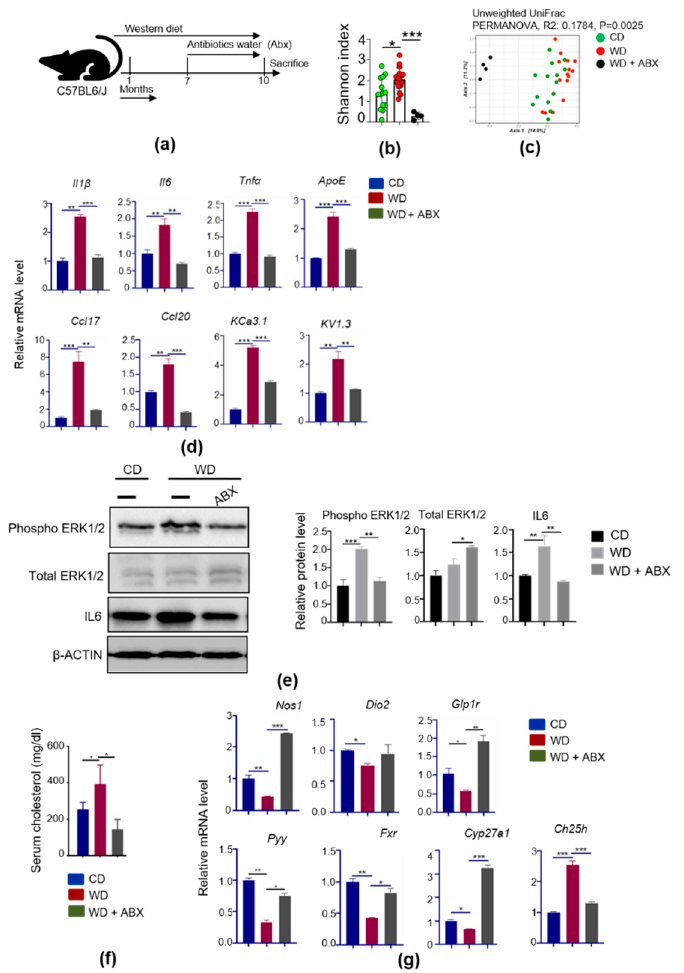
Figure 5. Microbiota depletion by antibiotics abrogated the inflammation induced by WD: ( a ) Experimental schema; ( b ) Shannon diversity index; ( c ) PCoA plot shows unweighted unifrac distance of fecal microbiota after 16S sequencing; ( d ) Relative mRNA level of inflammatory signaling genes in brain (CD, n = 6; WD, n = 6; WD with ABX, n = 4); ( e ) Western blot of inflammation signaling-related proteins in the brain of all experimental groups; ( f ) Serum cholesterol level and relative mRNA level of bile acid signaling genes in the brain of all experimental groups; ( g ) Relative mRNA level of bile acid receptor signaling genes in the brain. Data are expressed as mean ± SD. * p < 0.05, ** p < 0.01, *** p < 0.001, CD-fed compared with WD-fed mice, WD-fed mice compared with ABX (cocktail of ampicillin, neomycin, vancomycin, and metronidazole) treated